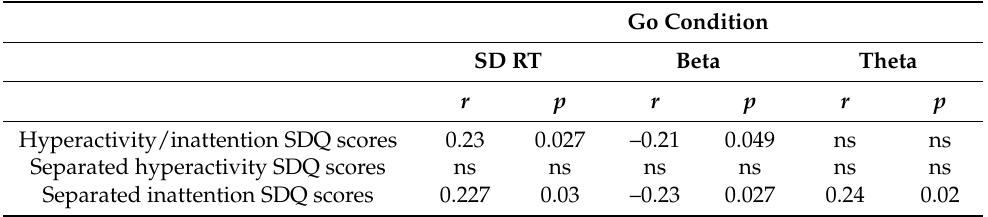
Table 2. The results of the partial correlation analysis under control of age and